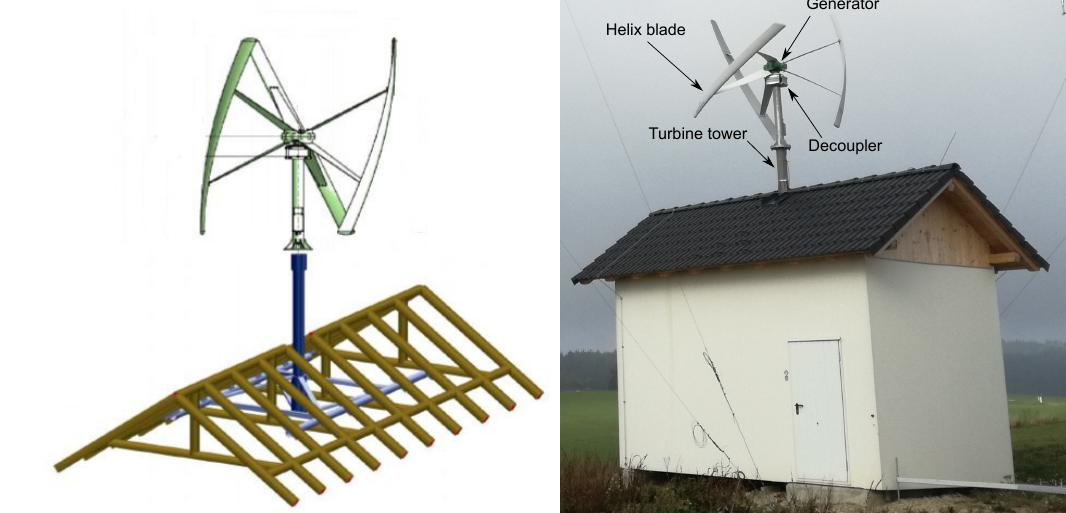
Figure 6. Rooftop support structure and picture of the experimental system composed by turbine, decoupler and